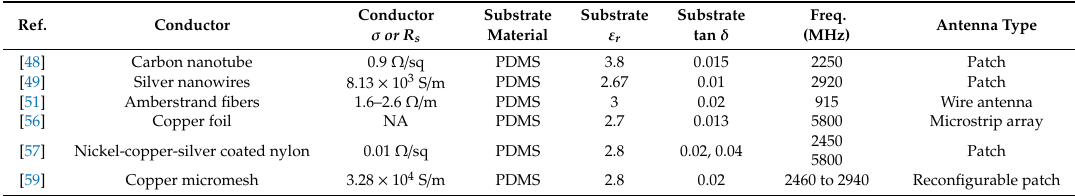
Table 3. Examples for embedded